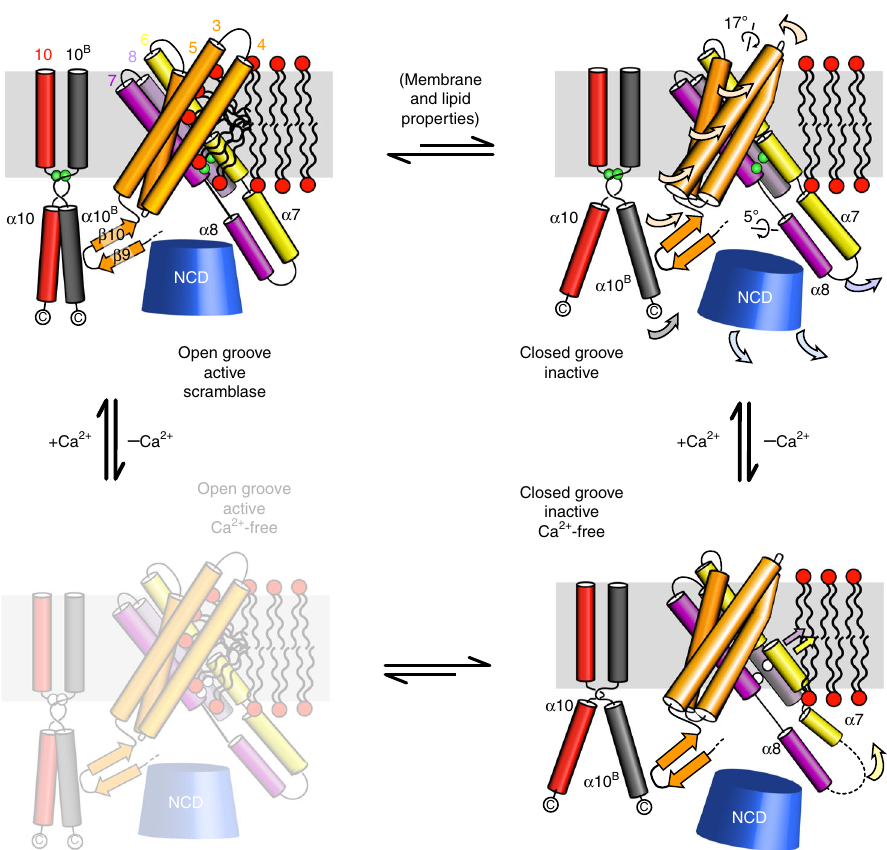
Fig. 8 Schematic of conformational changes in TMEM16K. Schematic summary of TMEM16K conformational states, with the N-terminal cytoplasmic domain (NCD) shown as a blue cone and lipids with headgroups (red) and aliphatic chains (black). Conformations for which the structure is unknown are shown with higher transparency, and are included for completeness of the